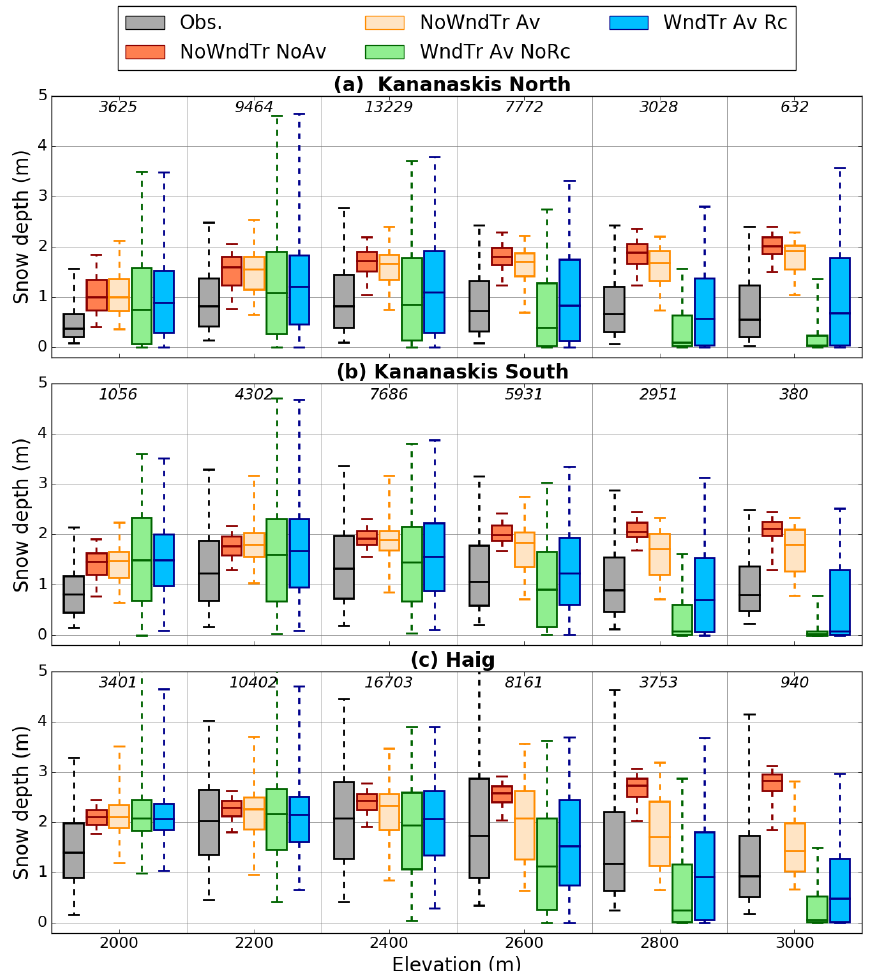
Figure 7. Boxplots showing the distributions of observed and simulated snow depth per 200m elevation band for three sub-regions. The location of these sub-regions is shown in Fig. 1b. Results of four CHM experiments are shown. The numbers in italic indicate the number of grid points within each elevation band. The whiskers show the 5th and 95th percentiles and outliers are not